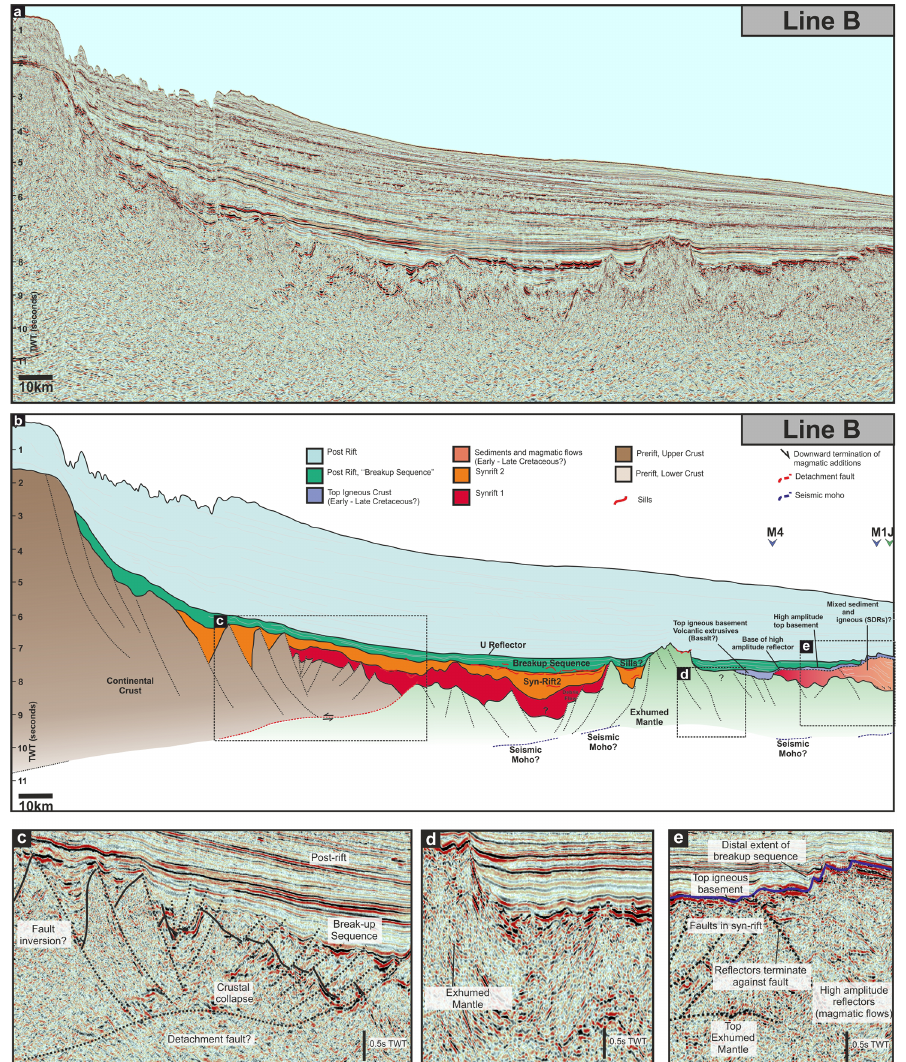
Figure 6. (a–b) Un-interpreted and interpreted seismic reflection profile (“Line B”) from the central Southern Newfoundland Basin. Inter- pretation shows the basement structure and sedimentary units. (c) Crustal collapse of the hanging wall along a large-scale landward-dipping fault resulting in extremely thinned continental crust. (d) Section of syn-rift sediments within the exhumed mantle zone. (e) Bright-amplitude oceanward-dipping reflectors interpreted as a mixture of sediment and magmatic flows beneath an igneous top basement. All data courtesy of